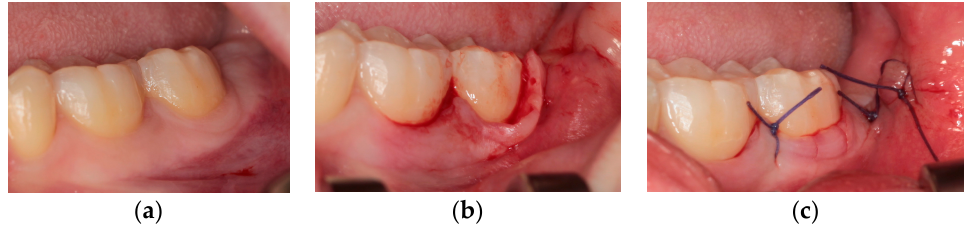
Figure 2. Marginal flap: ( a ) pre ‐ operative clinical view; ( b ) intra ‐ operative incisions; ( c ) final suture.